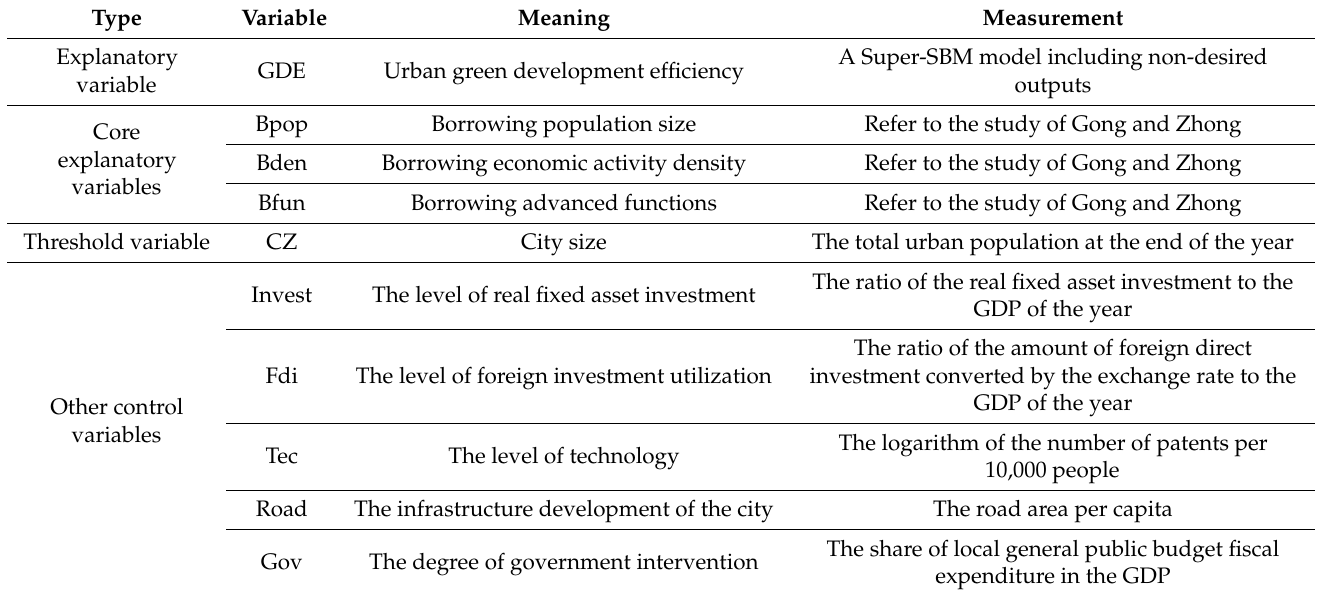
Table 2. Variable descriptions.